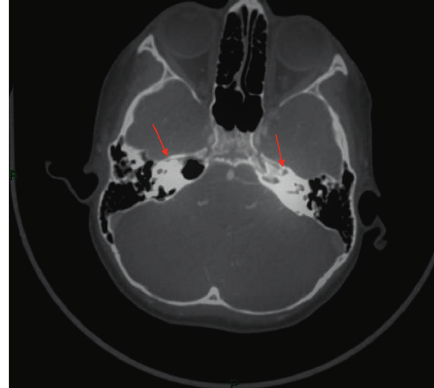
Figure 2: Skull base bone view with arrow showing obliteration for petrous bone carotid canal in the 6-year-old patient with bilateral ICA